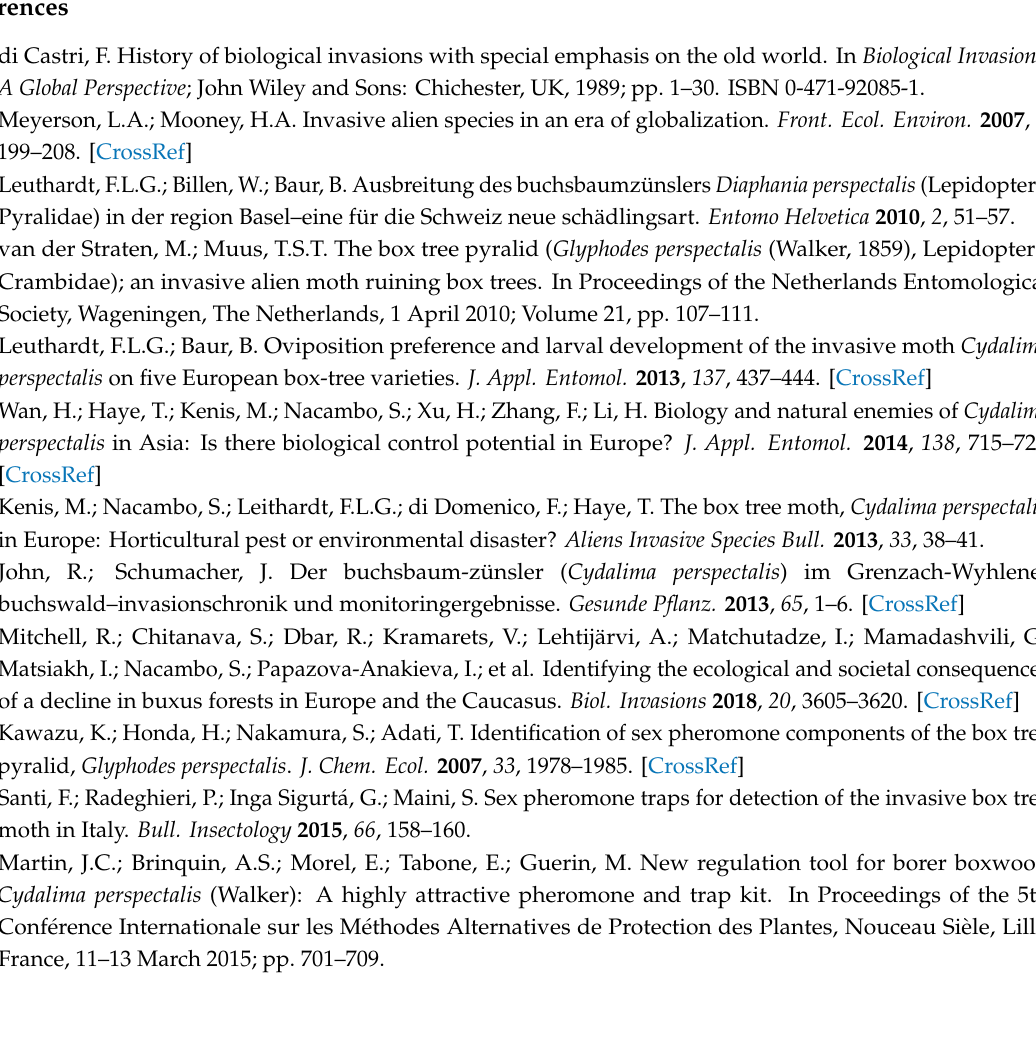
Figure S1: Evolution of the examined compounds over time in cinnamon (a), eucalyptus (b), and lavender (c). The fitted linear model shows trends for each of the compounds over time, Table S1: Chemical composition of Cinnamon, Eucalyptus and Lavender essential oils based on SPME headspace